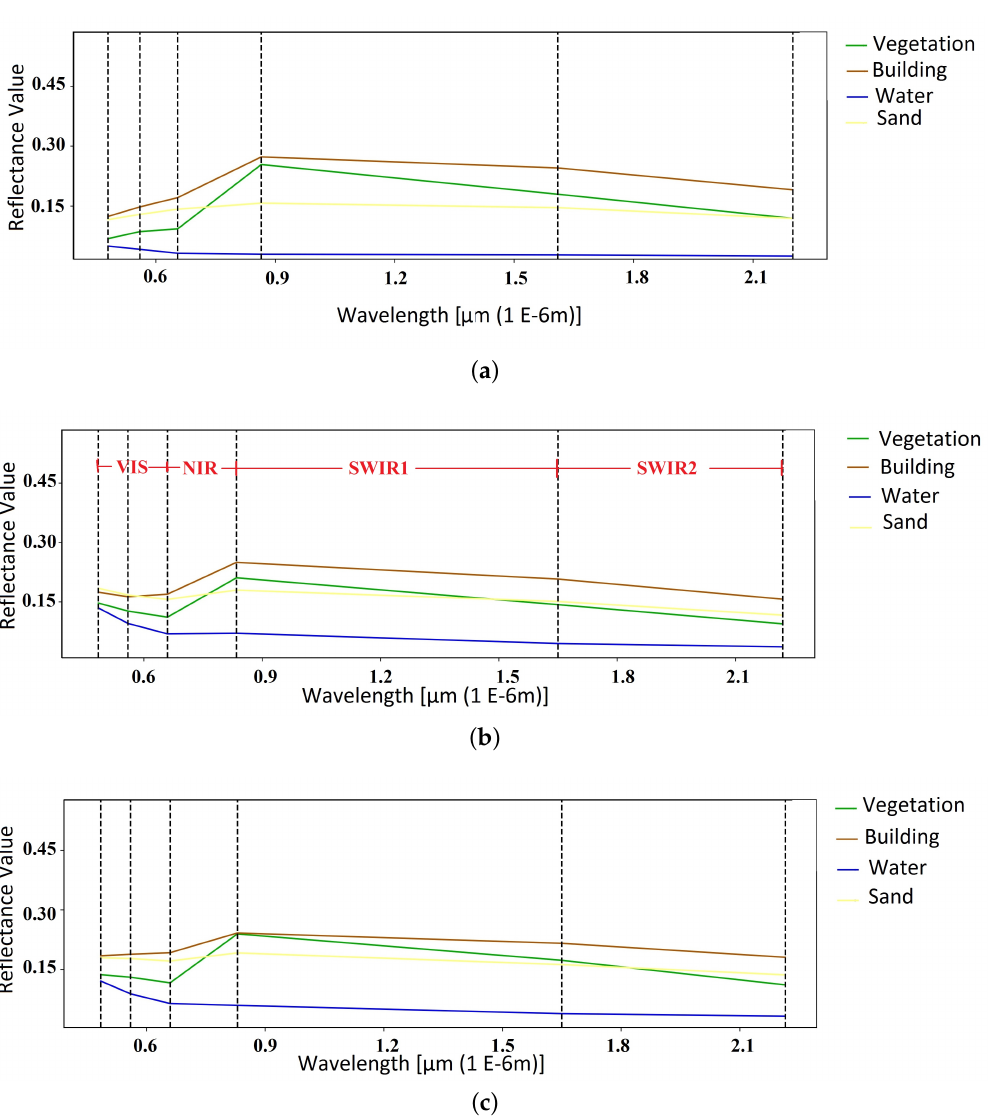
Figure 3. Spectral signature graphs of main land covers analyzed in the Guadalfeo Delta from different dates and Landsat sensors: ( a ) Operational Land Imager (OLI) Landsat image captured on 23 May 2013. ( b ) Enhanced Thematic Mapper Plus (ETM+) Landsat image captured on 25 October 2014. ( c ) Thematic Mapper (TM) Landsat image captured on 18 July